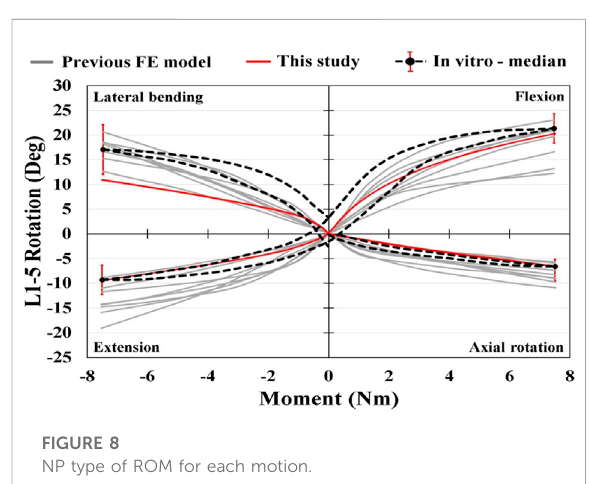
FIGURE 8 NP type of ROM for each